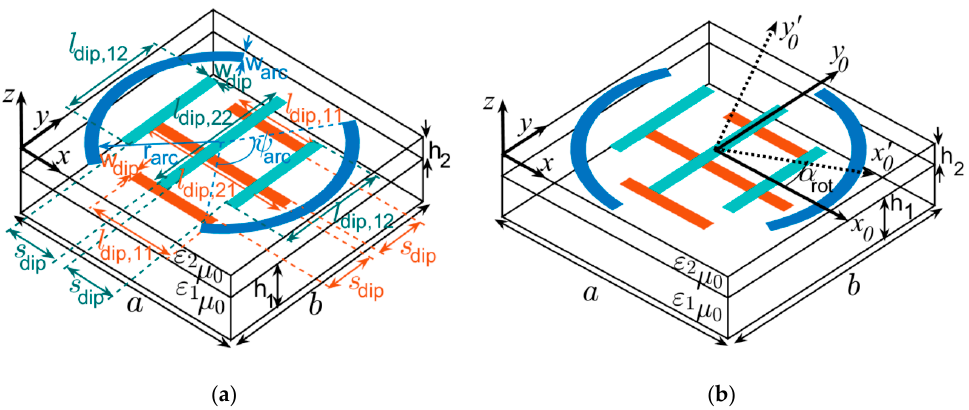
Figure 1. ( a ) Reflectarray element based on two orthogonal sets of parallel dipoles surrounded by a non-rotated split ring. ( b ) Reflectarray element with rotated split ring and definition of rotation angle α rot .